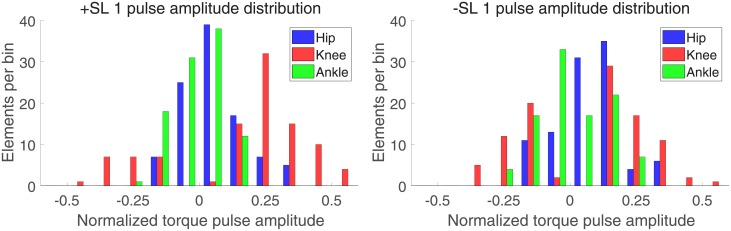
Histogram of one pulse approximation normalized amplitudes, sorted by SL modulation and joint.